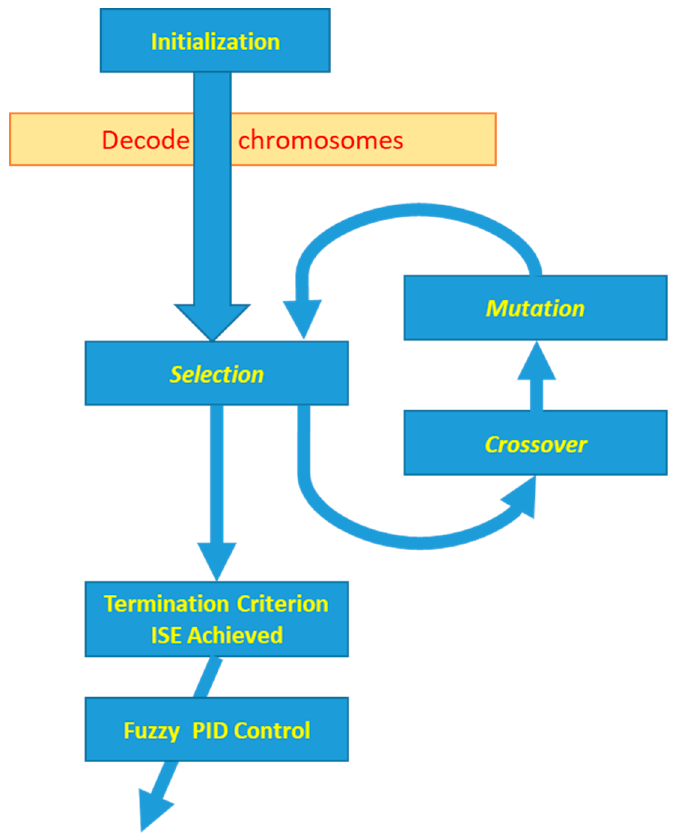
Figure 4. The proposed fuzzy-PID-mGA (fuzzy-proportional-integral-derivative modified genetic algorithm; the decode chromosome step is neglected).